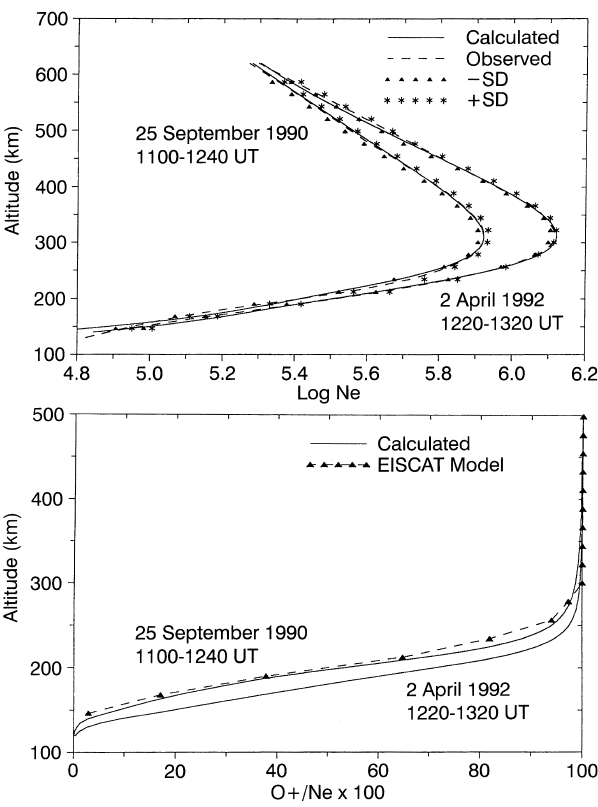
Fig. 4. Same as Fig. 3 but for geomagnetically quiet (5 August 1992) and disturbed (5 August